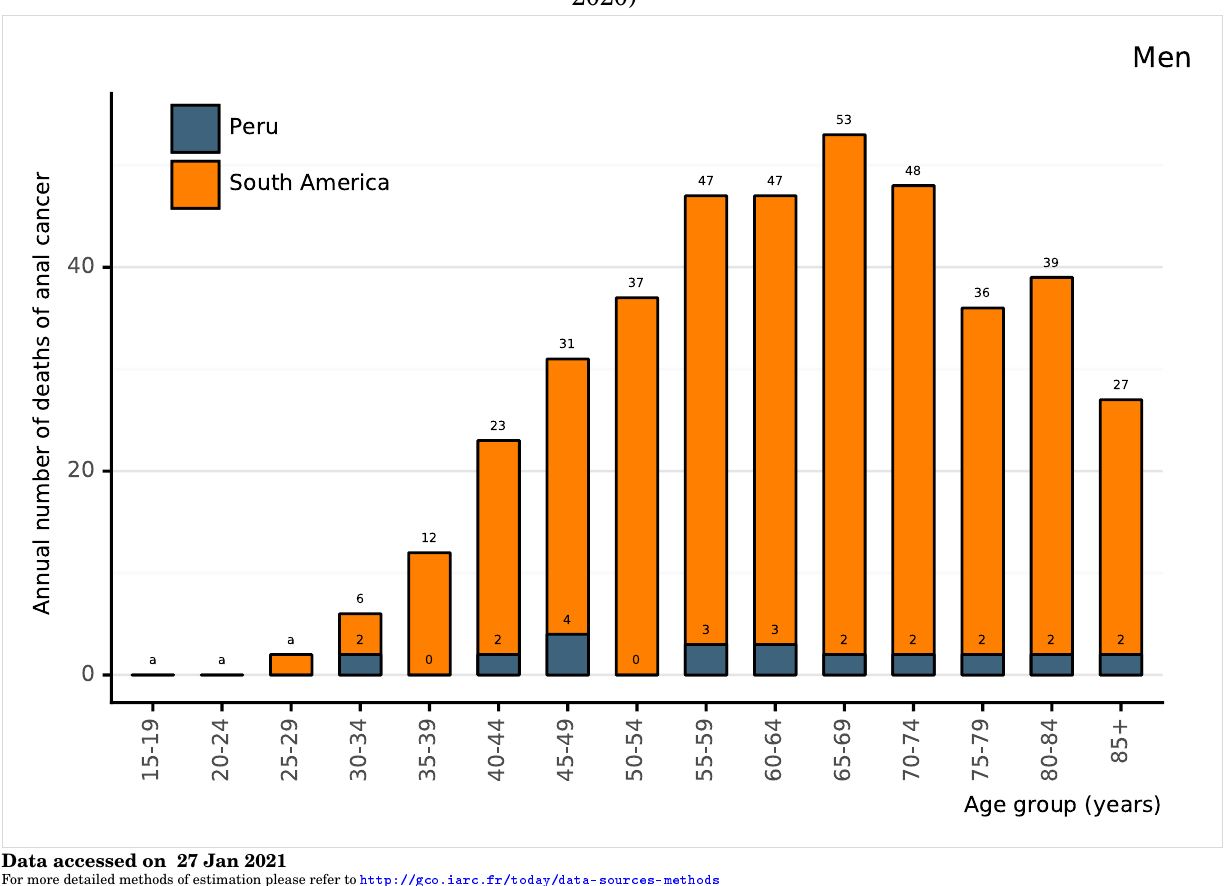
Figure 109: Annual number of deaths of anal cancer among men by age group in Peru (estimates